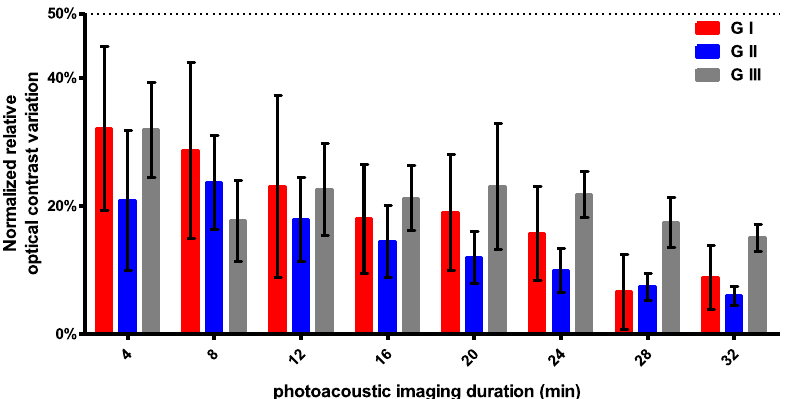
Fig. 6. Histogram of normalized relative optical contrast variation (means (cid:2) SEM) as the timeline for Group I, Group II and Group